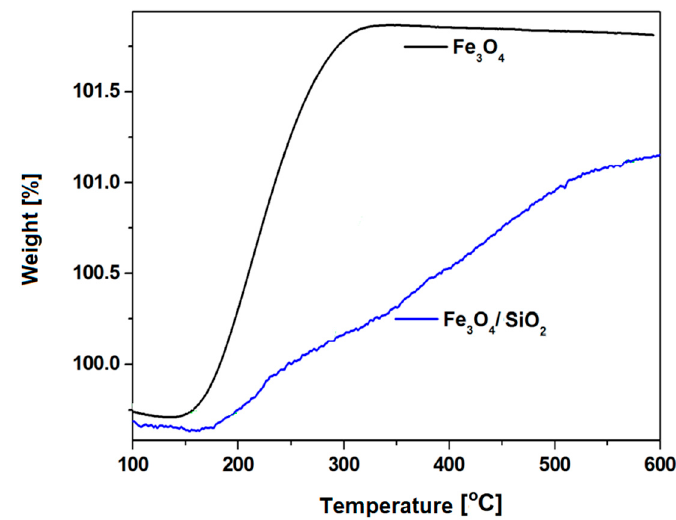
Figure 4. Thermogravimetric analysis of the magnetite nanoparticles (Fe 3 O 4 ) and magnetite nanoparticles with a solid silica shell (Fe 3 O 4 /SiO 2 ) (Reprinted with permission from [39]. Copyright 2017 Elsevier).